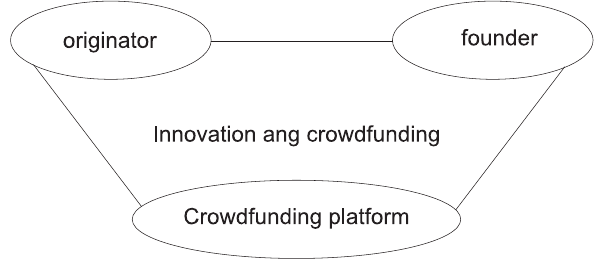
Figure 2. Simplified crowdfunding